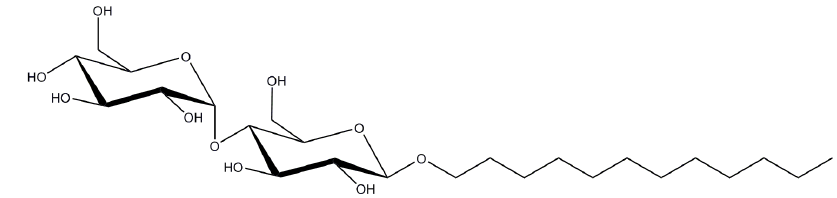
Figure 3. Structure of Layrul maltoside (DDM) (chemical formula is C 24 H 46 O 11 ).